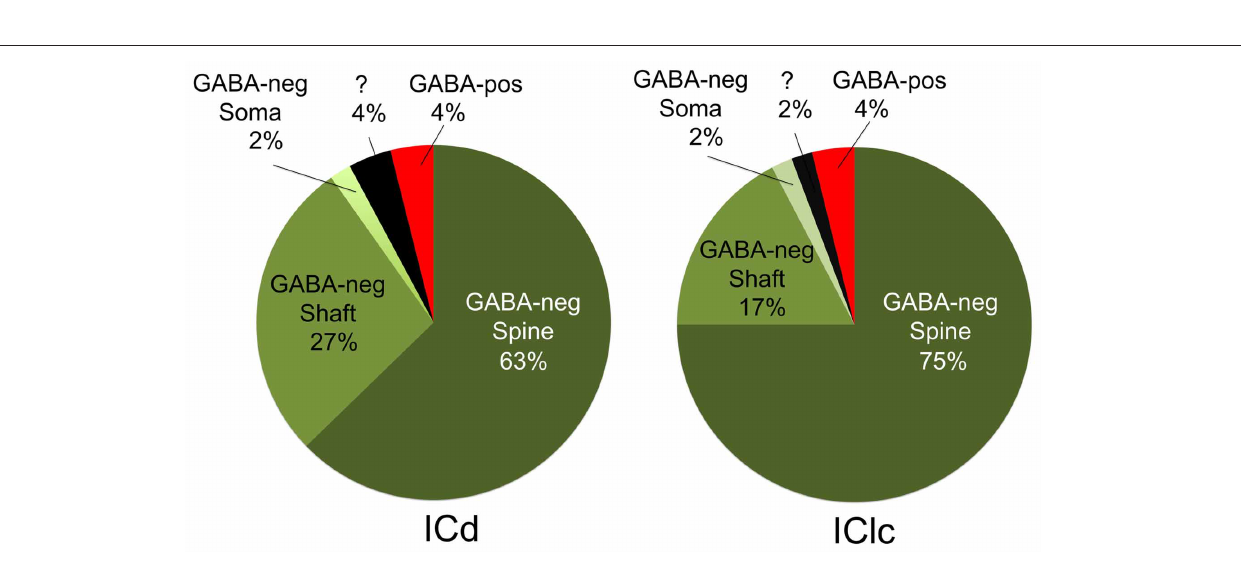
FIGURE 5 | Pie charts showing the frequency with which cortical boutons contact GABA-negative dendritic spines, GABA-negative dendritic shafts, GABA-negative somas and GABA-positive profiles. In both ICd and IClc, GABA-negative dendritic spines were the most frequent targets of cortical boutons, followed by GABA-negative dendritic shafts.